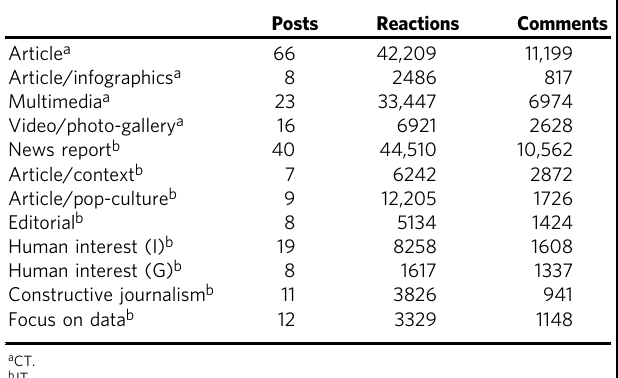
Table 1 Data breakdown of the posts, reactions and comments by their content type (above) and their journalistic technique (below).